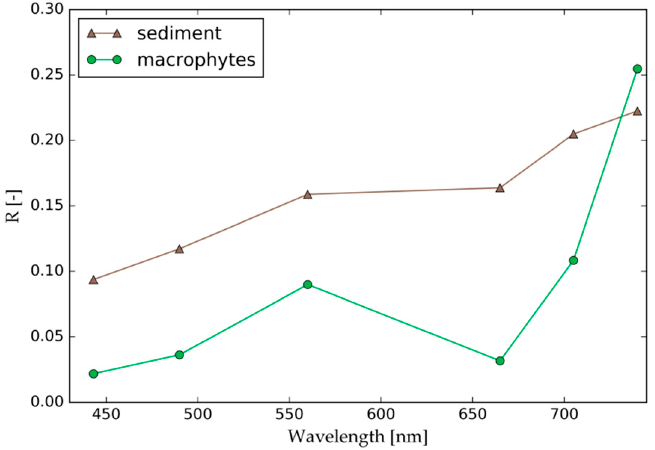
Figure 4. S2-A resampled irradiance reflectance spectra of the two considered bottom types. The sediment spectrum is the average of reflectance measurements on 13 August 2015, the macrophyte spectrum originates from the WASI-2D database.